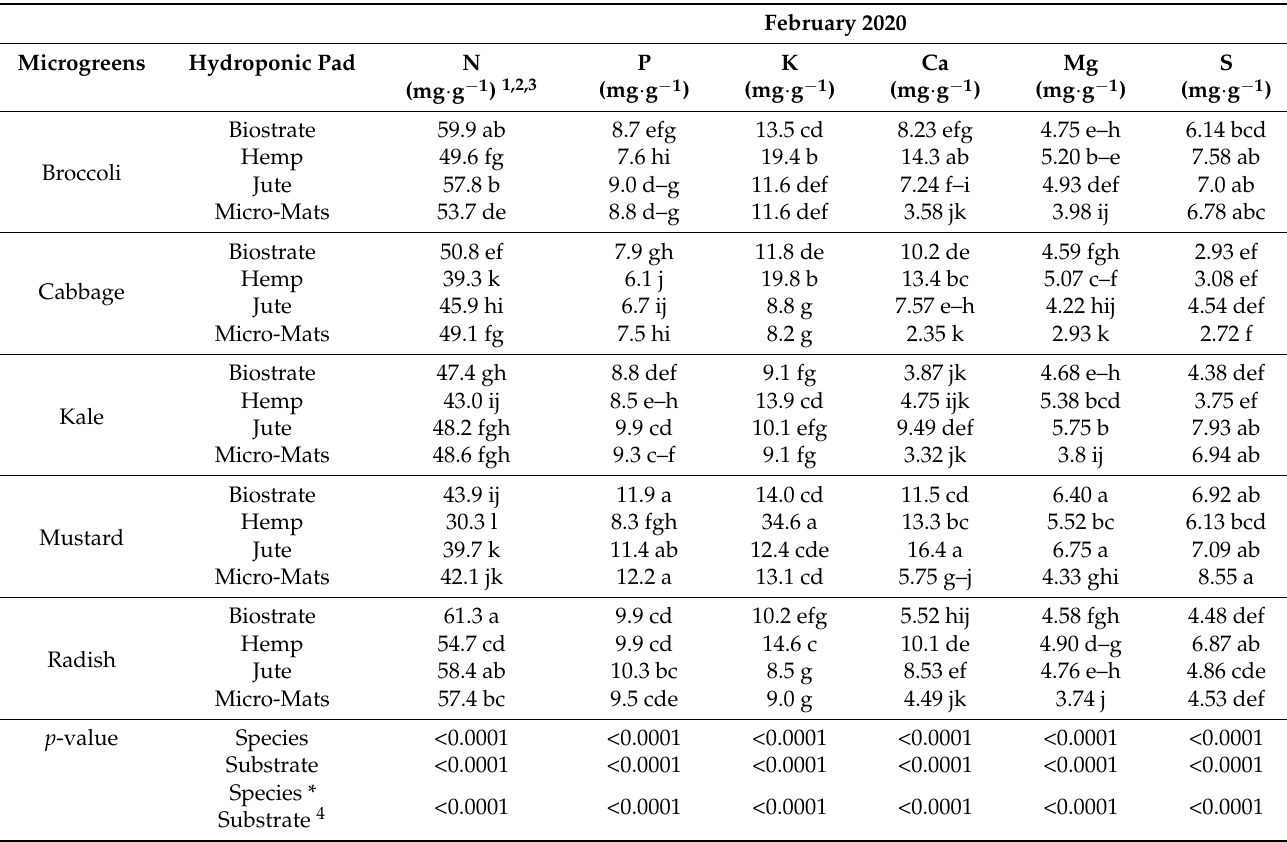
Table 8. Macronutrient concentrations in five microgreens affected by the interaction between species and hydroponic pad in February